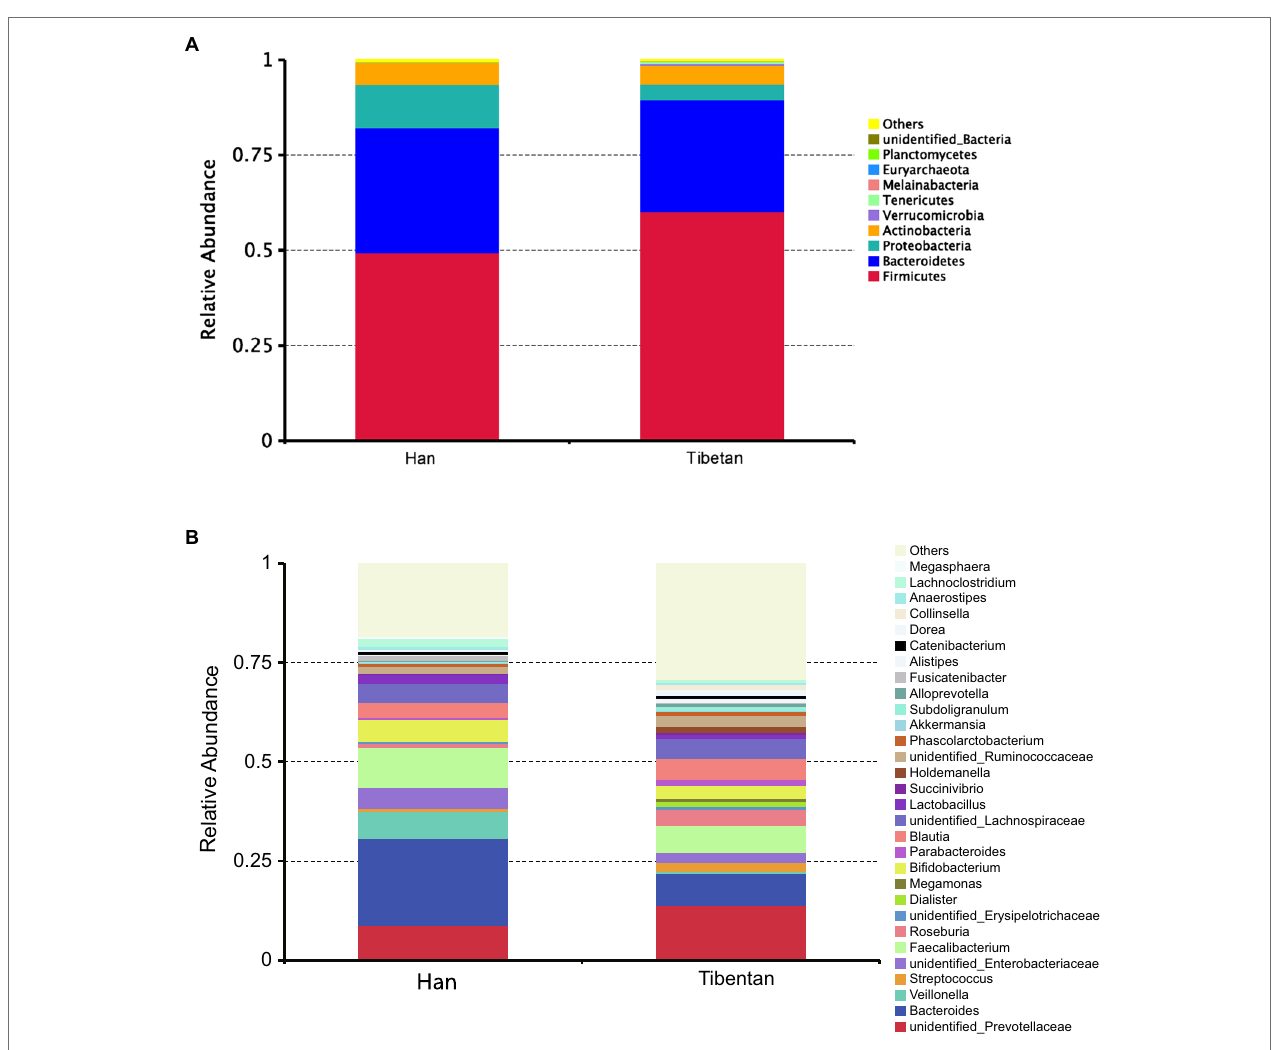
FIGURE 1 | Community composition of fecal microbiota in native Tibetans and Han immigrants. In the stacked bar chart, each bar represents the average relative abundance of each bacterial taxon. The taxa with high relative abundances at the phylum (top 10, A ) and genus levels (top 30, B ) are shown.